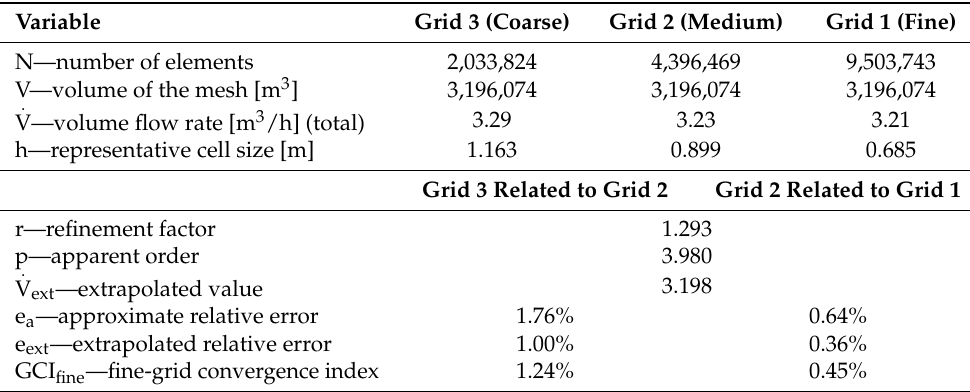
Table A1. Results from the reliability calculations of the generated